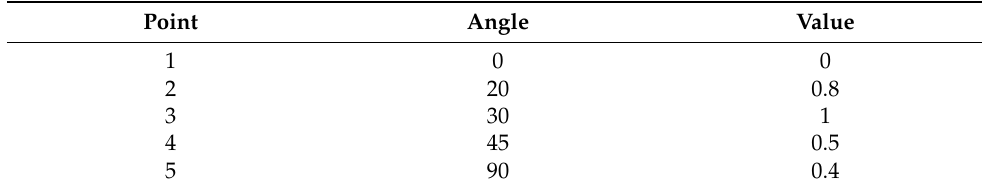
Table 1. Definition of impact angle function.